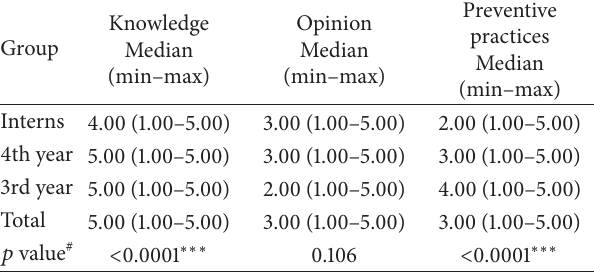
Table 4: Median (minimum–maximum) of knowledge, opinions, and preventive practices scores regarding infection control.